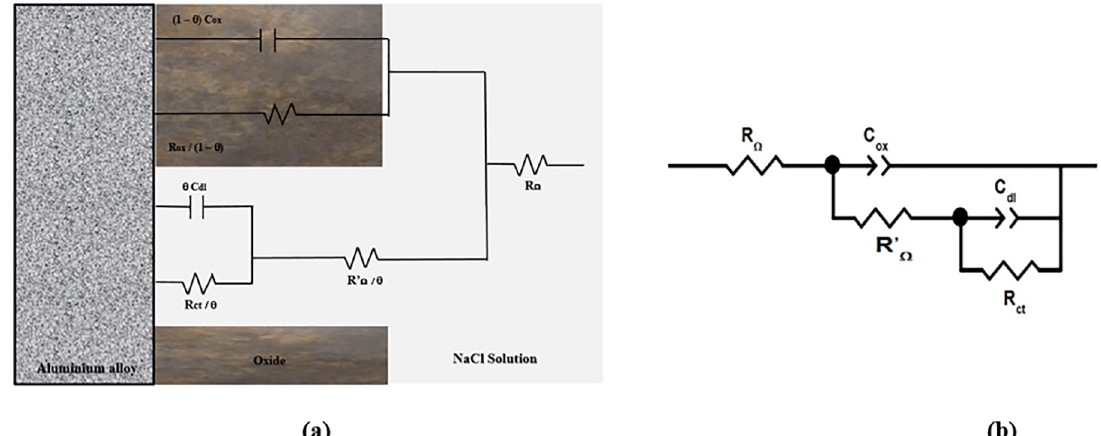
Figure 6. (a) Schematic representations of the model 25 and (b) proposed equivalent